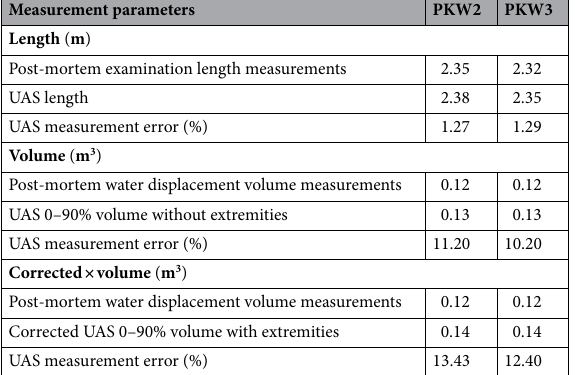
Table 1. Pygmy killer whale length (m) and volume (m 3 ) obtained from post-mortem water displacement and physical measurement compared to UAS-derived estimates that were collected on live animals at sea ~ 24 h prior to stranding on September 23, 2019. Volume of fins obtained using 3D scans were added to UAS volume estimates to obtain corrected